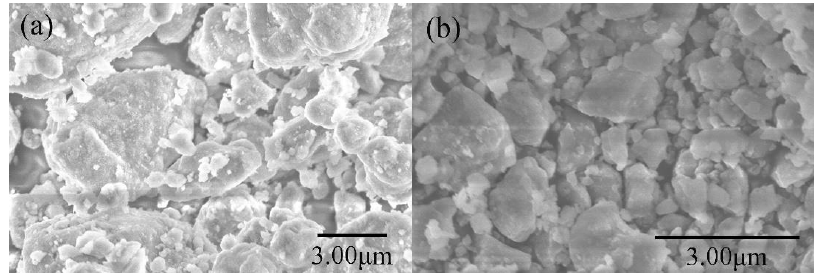
Figure 7. ( a ) SEM of MgH 2 -3 wt % LiH-G and ( b ) MgH 2 -3 wt % LiH-BM.